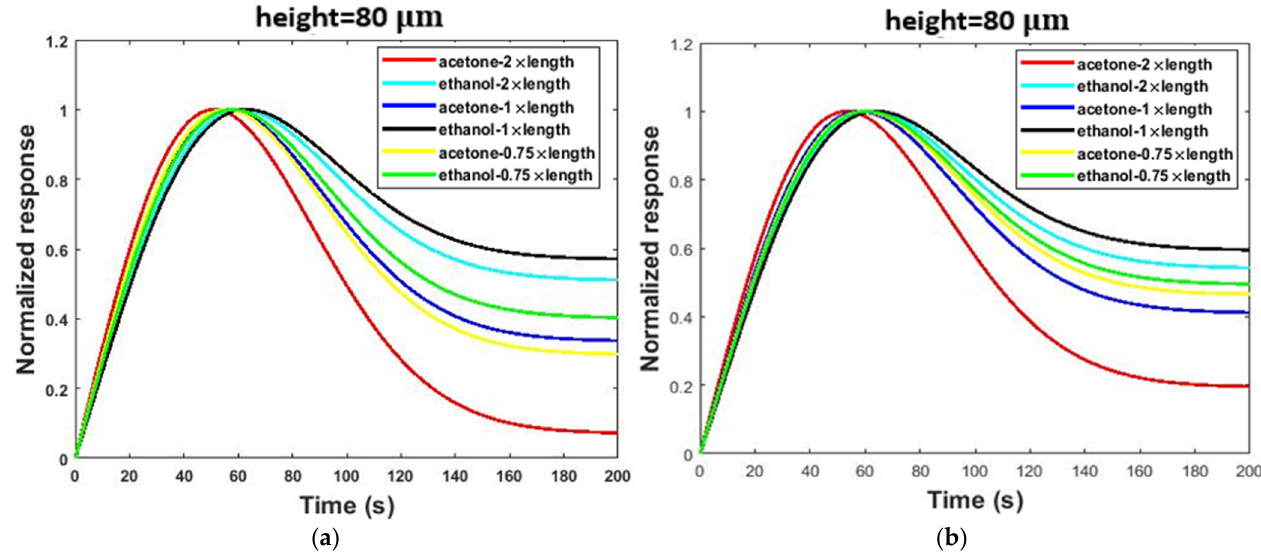
Figure 10. The effect of length variation of the channel on the selectivity of the sensor in the presence of 2.6 ppm acetone and ethanol gases in both the serpentine and simple models: ( a ) serpentine, ( b ) simple. Table 2. Comparison of calculated selectivity (S AB ) by changing the channel length of the sensor in the presence of 2.6 ppm acetone and ethanol gases in both the serpentine and simple models. Dimensions Simple Serpentine